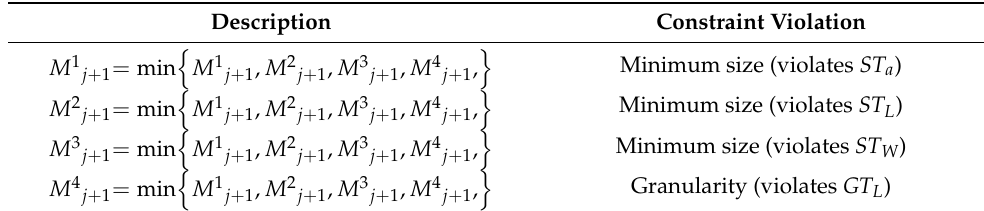
Table 1. Definitions of legibility constraint